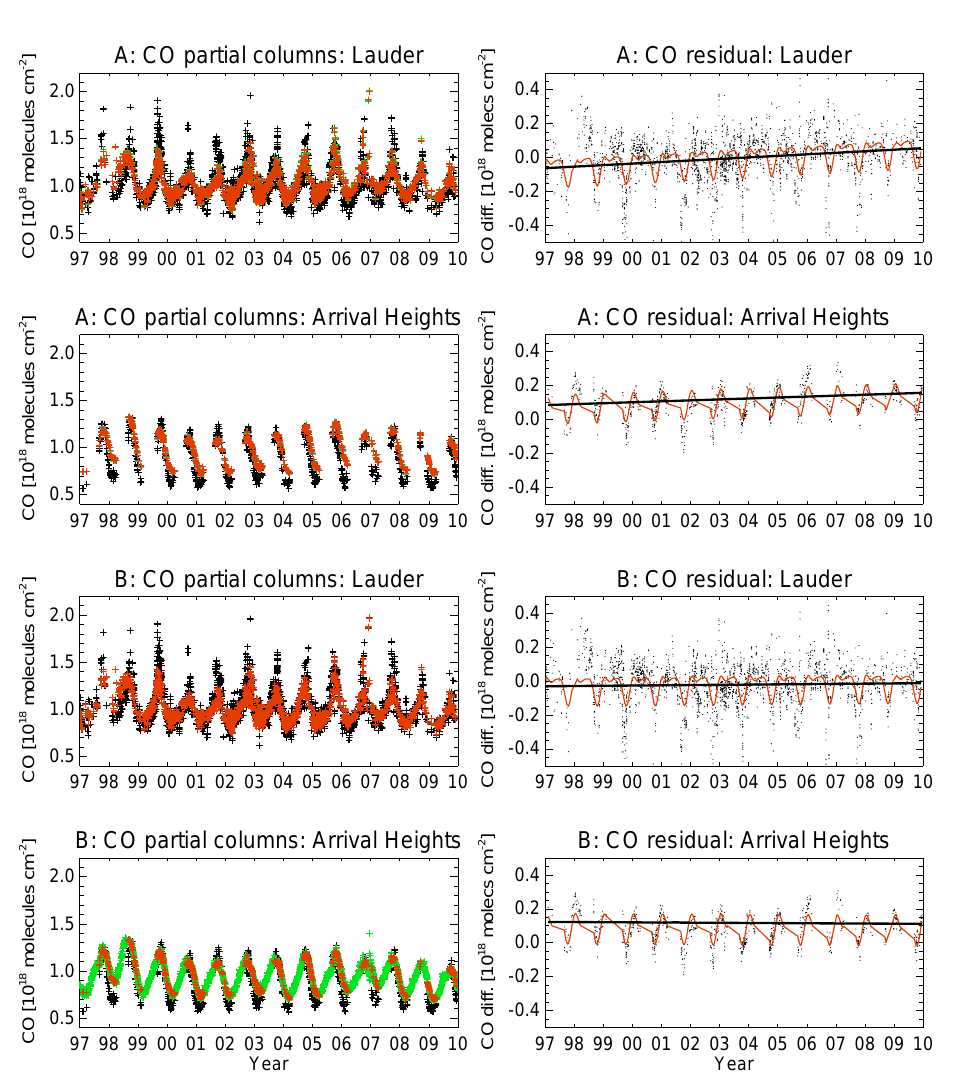
Fig. 5. Same as Fig. 4 but for